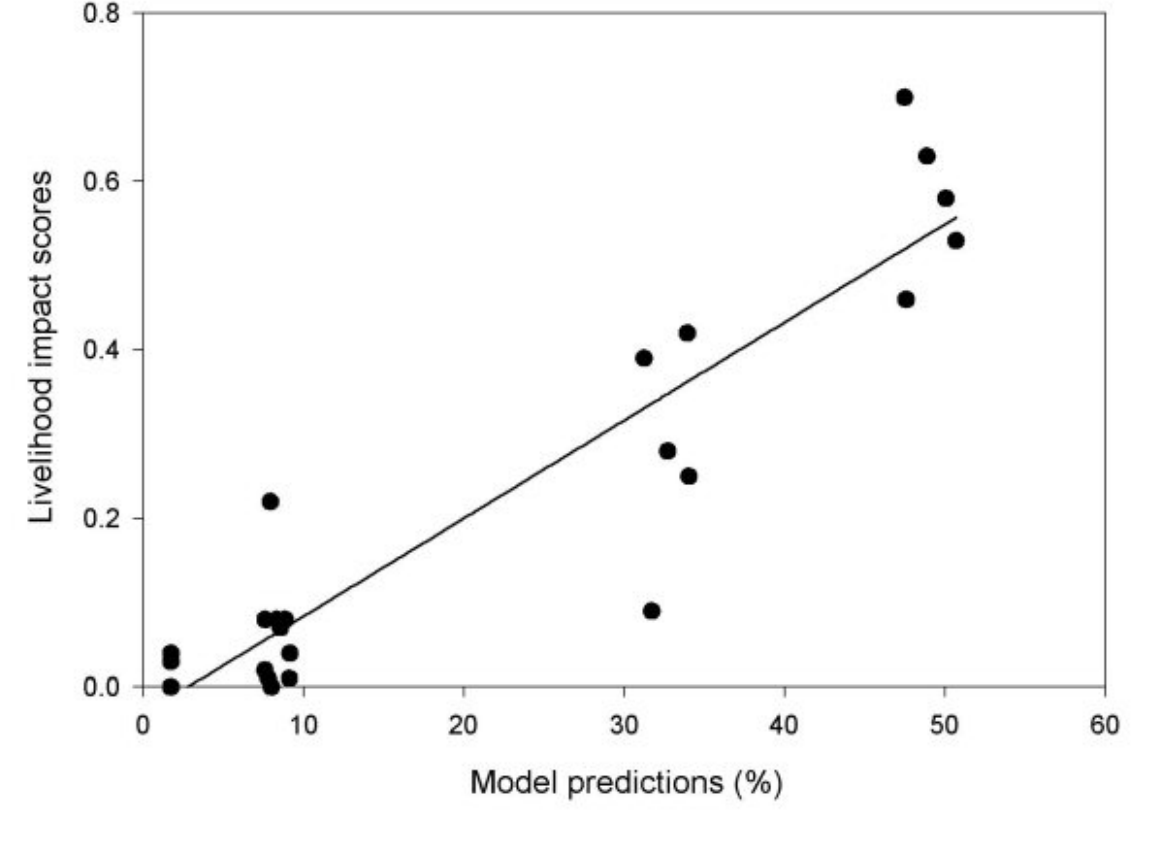
Fig. 4. Scatter plot illustrating the relationship between model predictions and livelihood impact scores, pooling the case studies together. Model predictions represent the probability values (represented as percentages) for the five states of nodes representing the changes in availability of assets required for livelihoods, treating different asset types separately. For these predictions, the network was instantiated with factor values for all NTFP case studies pooled together. Livelihood impact scores represent independent measures of the impact of NTFP commercialization on livelihoods assessed using the CIFOR indicators, pooling household- and community-level responses together, but treating each capital asset type